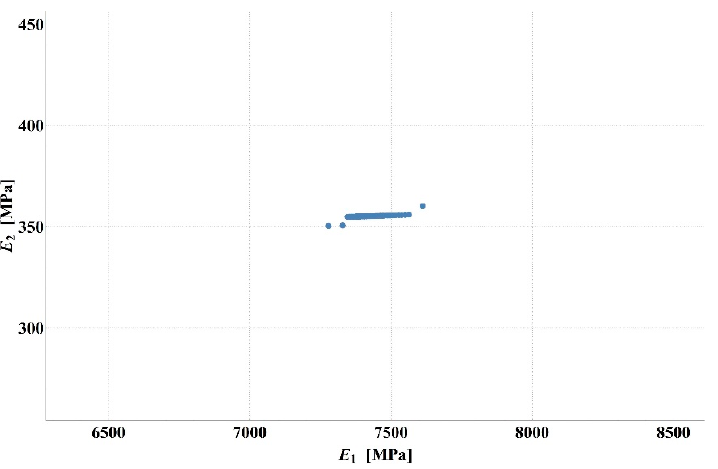
Figure 6. Values of asphalt layer and aggregate base course stiffness moduli for D2S variant of measurement